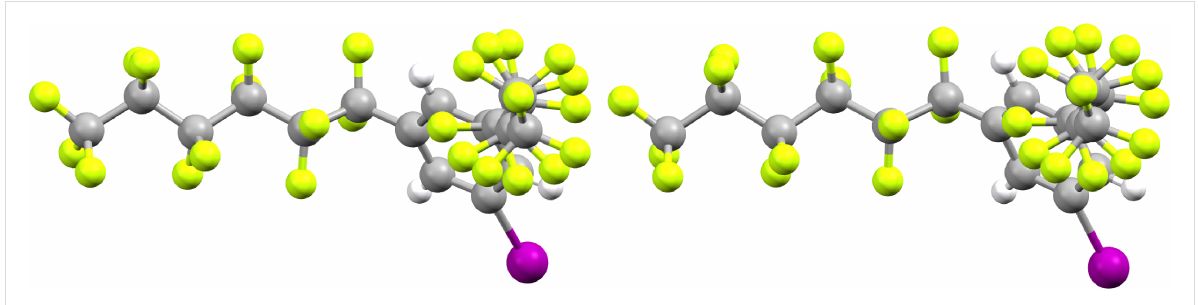
Figure 5: Views of the helical motif of the perfluorohexyl segments in crystalline 1,3,5-(R f6 ) 2 C 6 H 3 I (left) and the structure computed by DFT calcula- tions